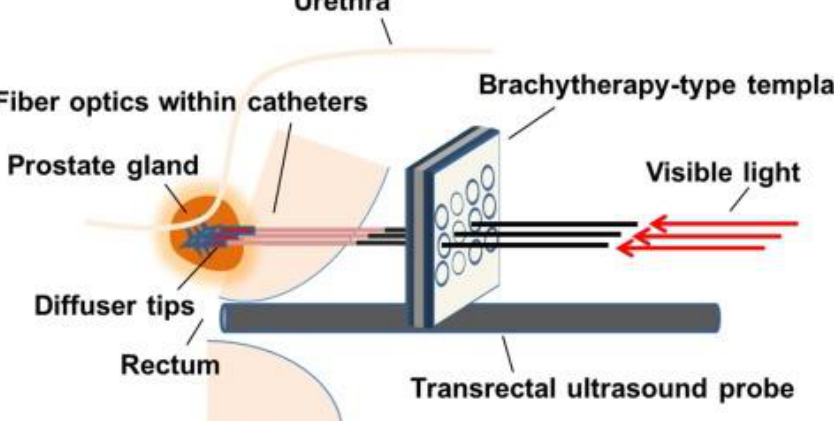
Figure 2. A generalized diagram depicting the use of a brachytherapy-type template and transrectal ultrasound to precisely guide catheters containing fibre optics to the prostate gland for PDT. Reproduced with permission from M. Osuchowski, Photodiagnosis Photodyn. Ther. 2021 [73].